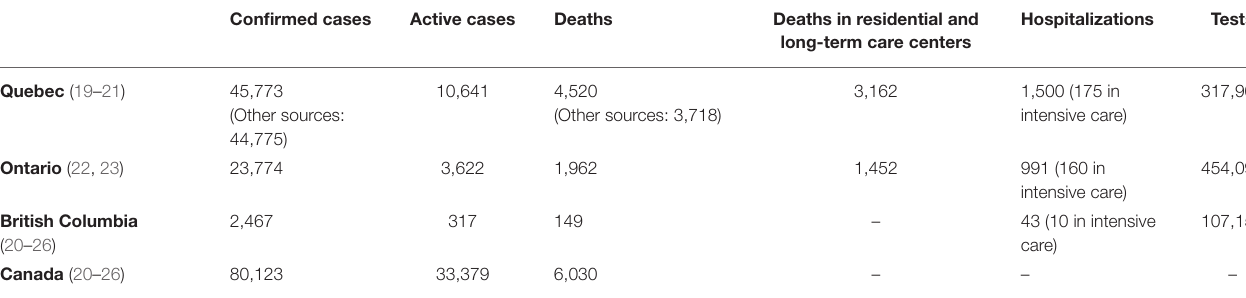
TABLE 1 | COVID-19 data for selected provinces (Quebec, Ontario, British Columbia) and at the Canadian level, as of May 20,